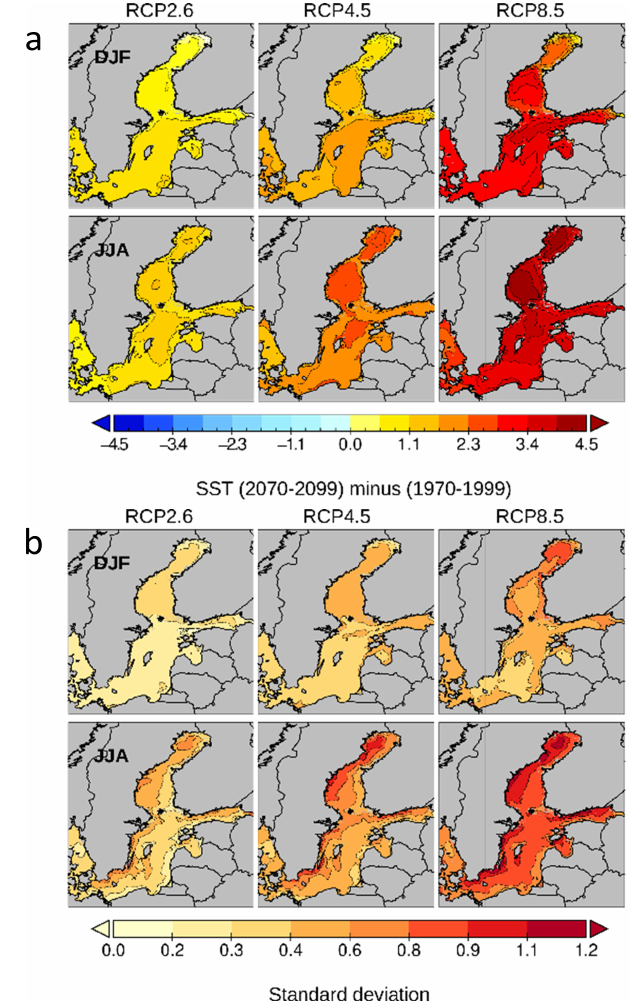
Figure 30. (a) Ensemble mean sea surface temperature change (de- grees Celsius) between 1970–1999 and 2070–2099 for winter (De- cember through February; upper panels) and summer (June through August; lower panels) under RCP2.6, RCP4.5, and RCP8.5. Panel (b) is the same as panel (a) but for the standard deviation of the change, i.e. the ensemble spread (degrees Celsius). In total, eight different dynamically downscaled Earth system model (ESM) sim- ulations are used. Data source: Gröger et al.,